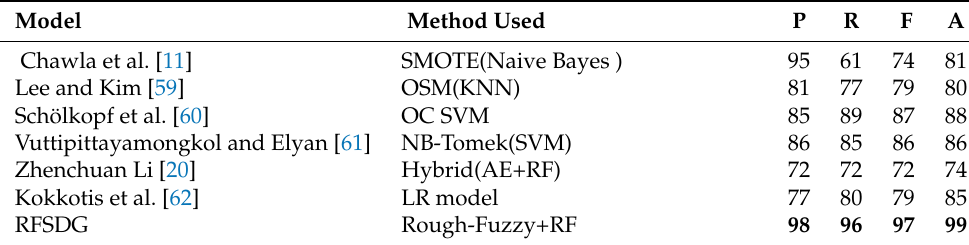
Table 3. Comparison (in %) of different methods on Credit-card data.